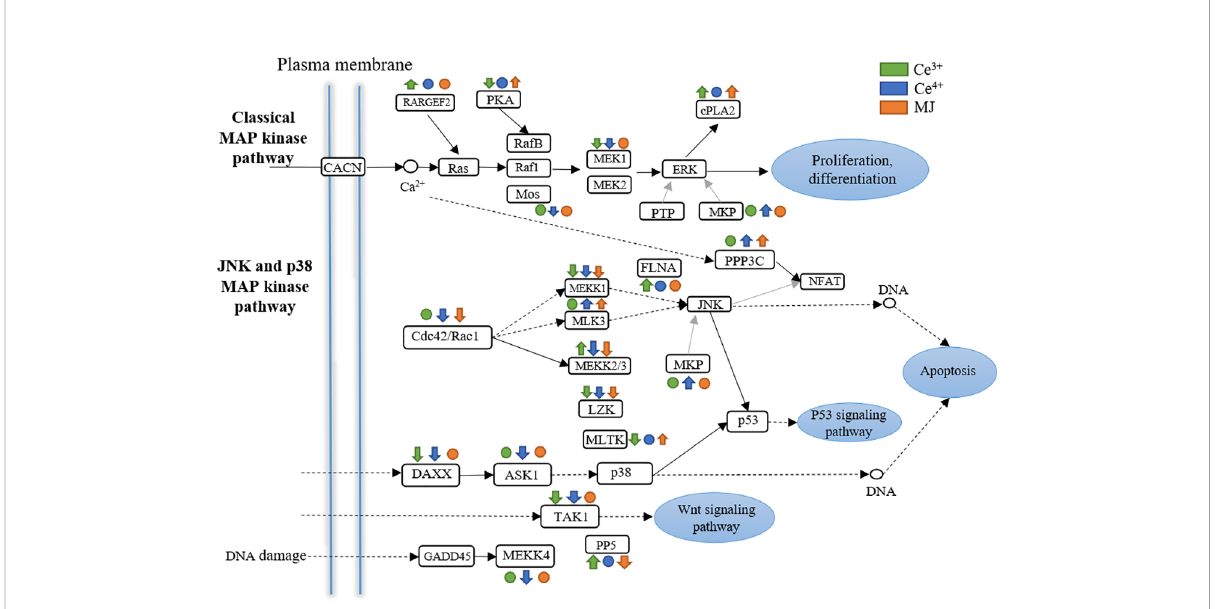
FIGURE 9 DEGs assigned to MAPK signaling pathway in C6h-vs-CeA6h, C6h-vs-CeB6h and C6h-vs-M6h. Green is elicited by Ce3+, blue is Ce4+, orange is MJ. The up arrows indicate the upregulation of gene expression; the down arrows indicate the downregulation of gene expression; the circles indicate unchanged